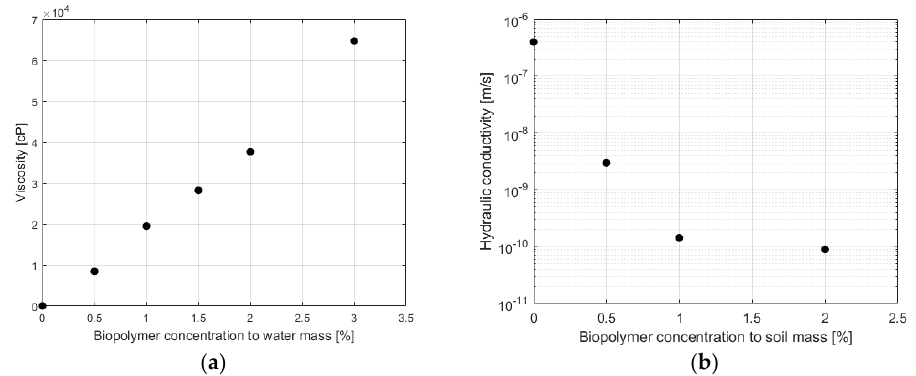
Figure 4. ( a ) Viscosity measurements of the blended biopolymer at different concentrations in relation to the mass of water. ( b ) Hydraulic conductivity of the blended biopolymer-treated standard sand (Jumunjin sand) at different concentrations in relation to the mass of the soil.